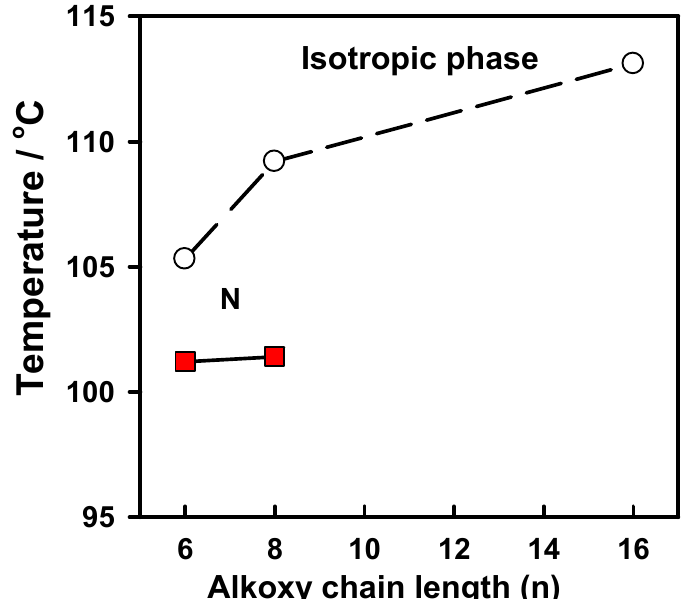
Figure 3. Graphical DSC transitions for derivatives I n.